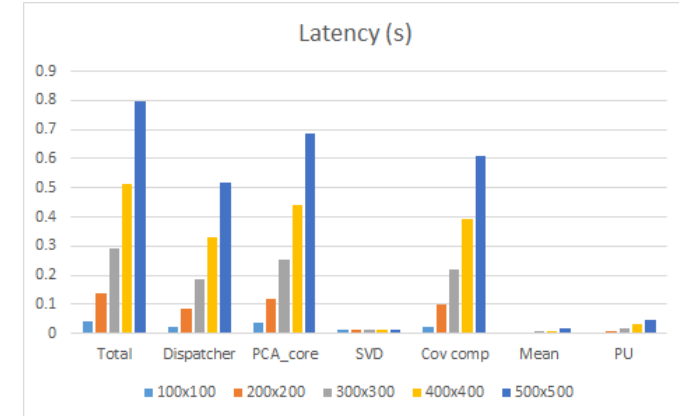
Figure 10. Impact of the number of pixels on the latency for Virtex7, bands = 48, B max = 8, floating-point design.